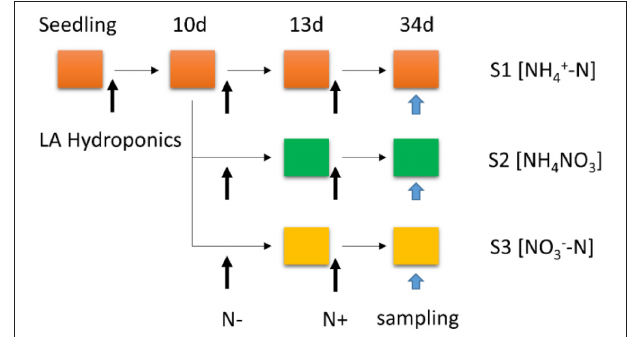
FIGURE 1 | Schematic representation of the experimental set-up: poplar plants were grown hydroponically in complete LA liquid medium (N + medium) for 10 days, then transferred to nitrogen-free medium (N − medium) for 3 days; subsets of plants were transferred back to complete medium (N resupply, S1 [NH + 4 -N]; S2 [NH 4 NO 3 ]; S3 [NO − 3 -N]) for another 21 days. The total treatment period is 34